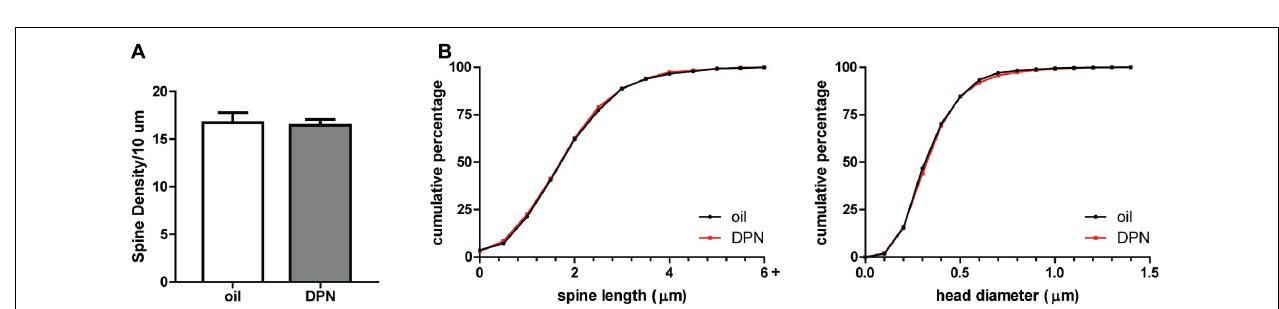
FIGURE 2 | DHT decreases spine density in the NAcSh of castrated male rats. (A) Average spine density per 10 µ m of MSNs in the NAcC 24 h after systemic administration of DHT (1.5 mg) or oil control. (B) Spine morphology of MSNs in the NAcC as assessed by binned cumulative probability distributions of spine length and head diameter in oil and DHT treated groups. (C) Average spine density per 10 µ m of MSNs in the NAcSh 24 h after systemic administration of DHT (1.5 mg) or oil control. (D) Spine morphology of MSNs in the NAcSh in oil and DHT treated groups. n = 6 animals per group with spine density averaged from 6 to 9 dendritic segments per each subregion for each animal, ∗ p < 0.05.